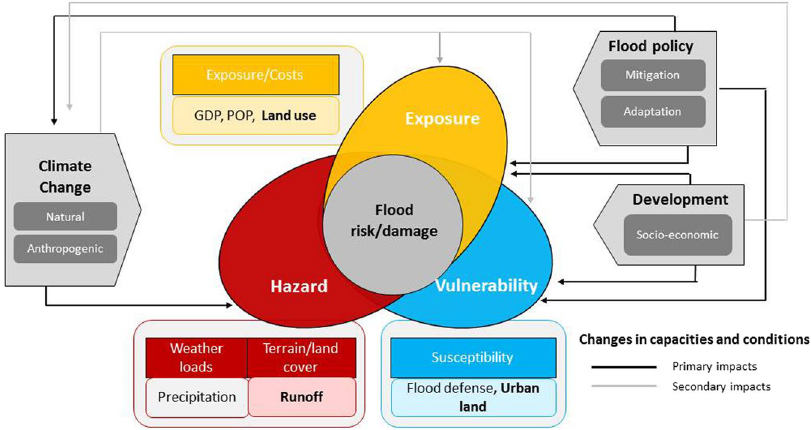
Figure 1. Conceptual framework for analyzing flood damage variations. Figure was created using Adobe Illustrator CS6 software